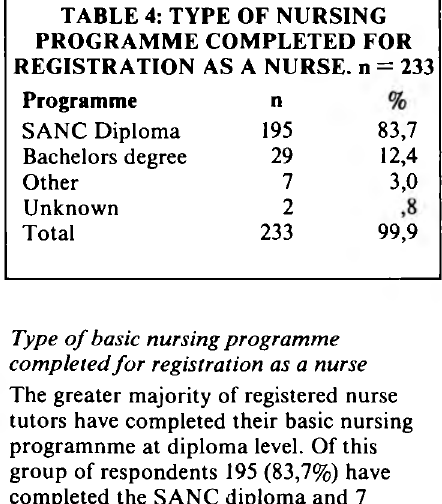
TABLE 4: TYPE OF NURSING PROGRAMME COMPLETED FOR REGISTRATION AS A NURSE, n = 233